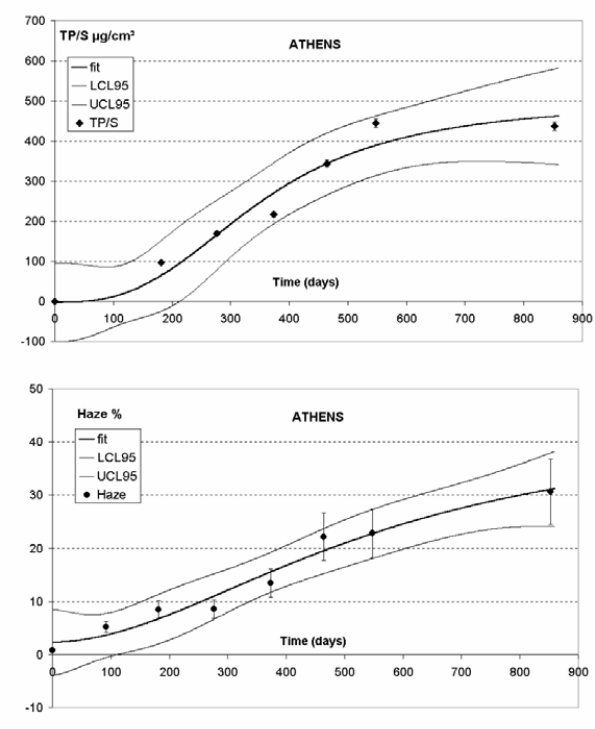
Fig. 12. Time evolution of TP/S (µgcm − 2 ) and haze (%) for mod- ern glass in Athens: best-fitting Hill model (fit) with the estima- tion confidence band (LCL95: Lower Confidence Level of 95%; UCL95: Upper Confidence Level of 95%) and experimental data with error bars (from Ionescu et al., 2006).